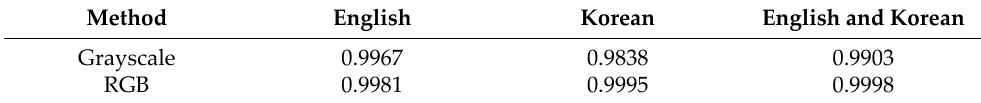
Table 9. Spam detection performance using CNN 2D